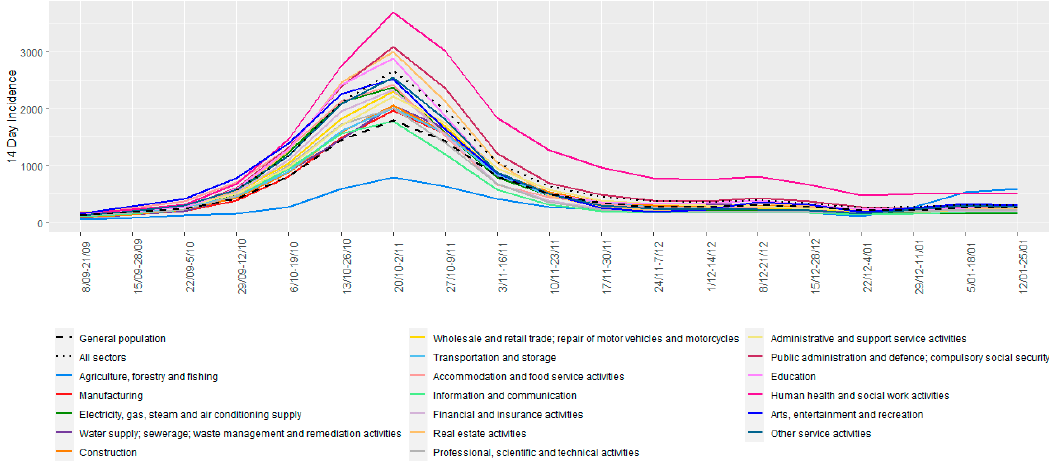
Figure 3. The 14-day incidence of COVID-19 in sectors with a minimum of 10,000 employees at level 1.